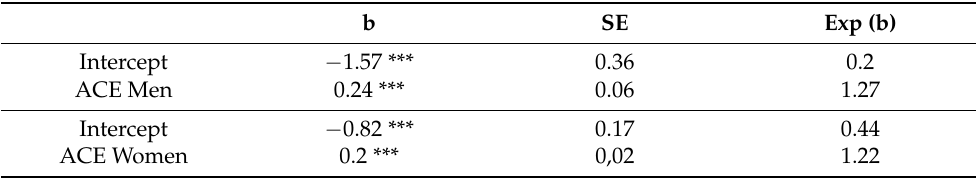
Table 11. Poisson model for mental health problems by